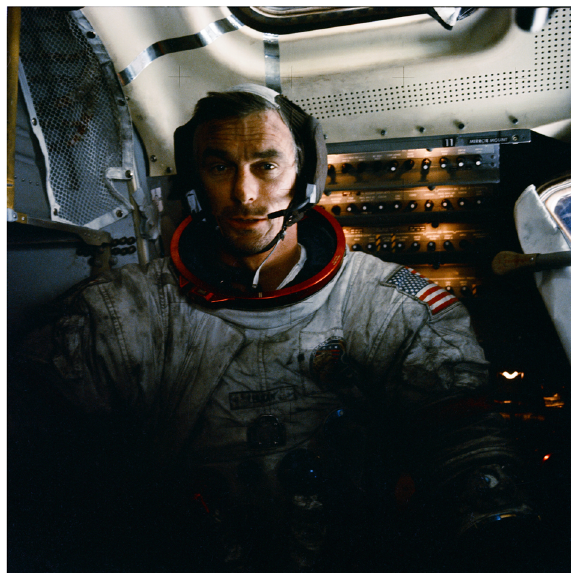
Fig. 3 Lunar dust adherent to spacesuit. Gene Cernan, Apollo 17 commander, is seen with his spacesuit covered in lunar dust following an EVA. Lunar dust can also be seen adhering to the interior of the lunar module 83 . Copyright © NASA Public Domain